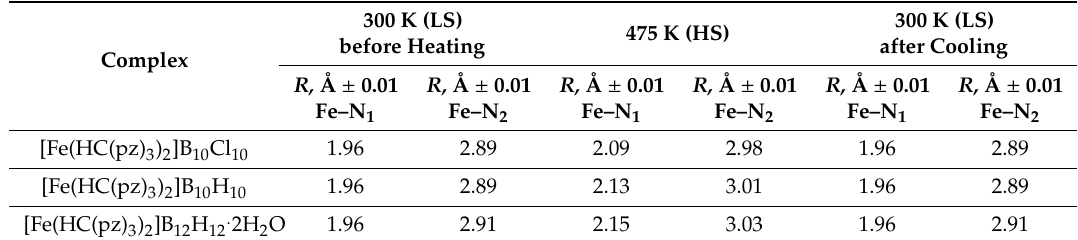
Table 3. Modeling of experimental Fe K-edge EXAFS spectra. Fe–N 1 and Fe–N 2 are average distances to the nitrogen atoms in the environment of the iron